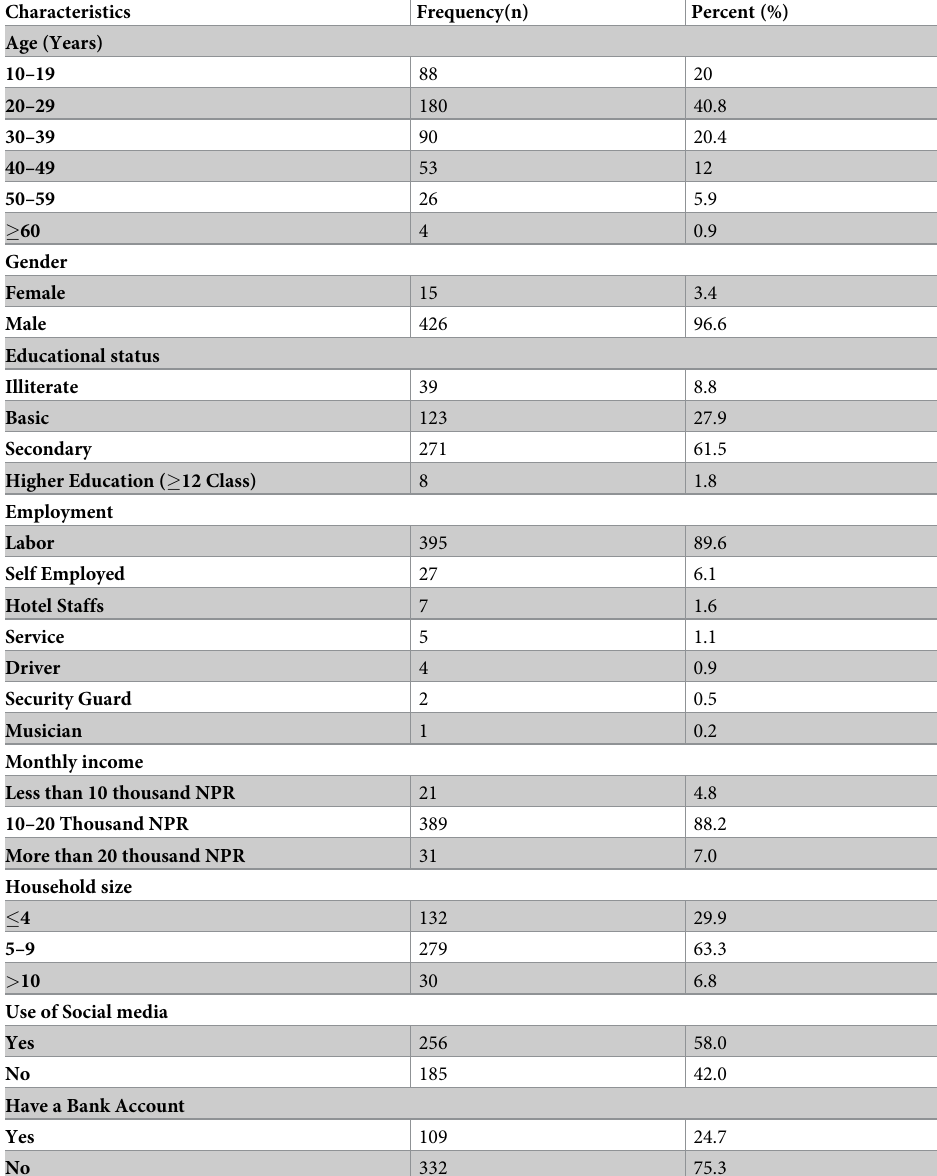
Table 1. Socio-demographic characteristics of participants in quantitative survey (n =